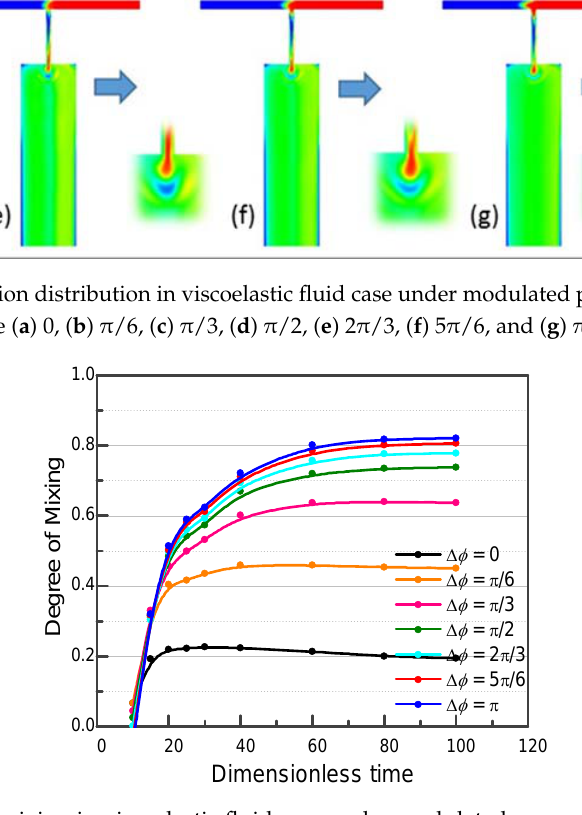
Figure 9. Degree of mixing in viscoelastic fluid case under modulated pressure at both inlets with phase difference from 0 to π .